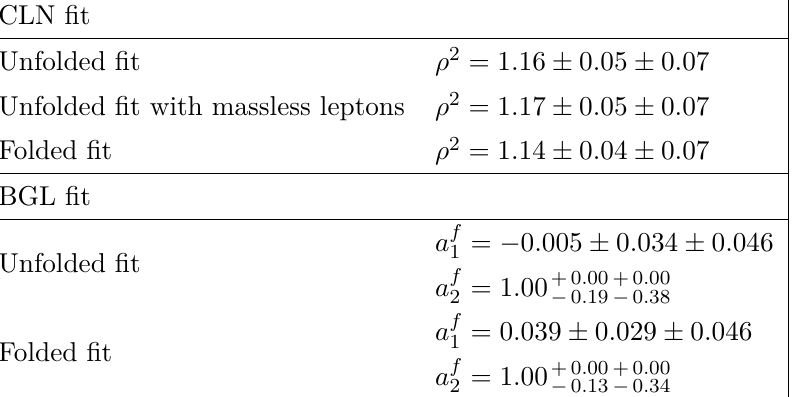
Table 5 . Results from different fit configurations, where the first uncertainty is statistical and the second